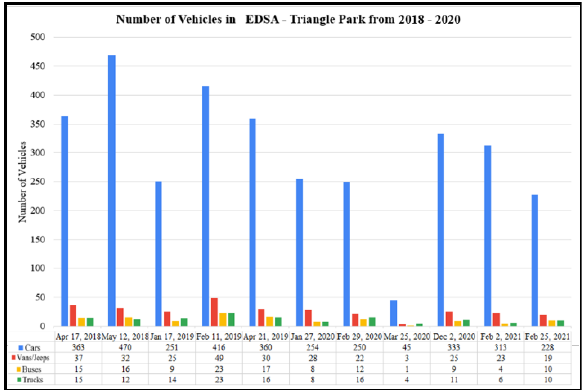
Figure 7. Number of Vehicles per Classification in EDSA Triangle Park, Eastwood City from 2018-2021